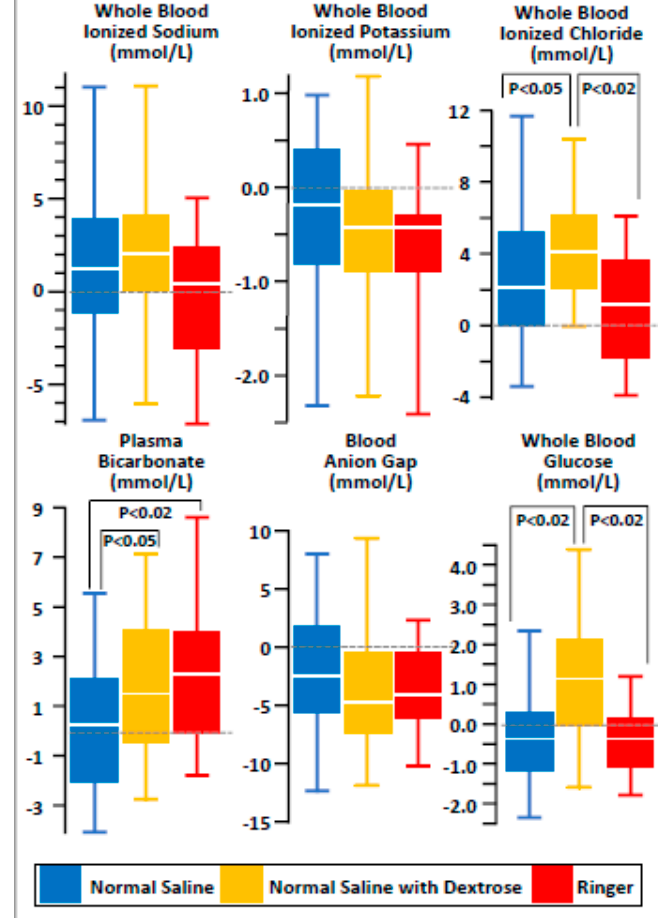
Figure 1. Changes in ionized sodium, potassium, chloride, bicarbonate, anion gap and glucose after short-term maintenance intravenous fluid therapy using normal saline (N = 56), dextrose-supplemented saline (N = 48) or lactated Ringer’s (N = 30) solution in children with mild to moderate acute gastroenteritis and failure of oral rehydration therapy. The results are given as “box-and-whisker diagram”: bottom and top of box represent the 25 th and the 75 th centile, respectively, middle of box the 50 th centile (the median), ends of whiskers the 5 th and the 95 th centile, respectively.